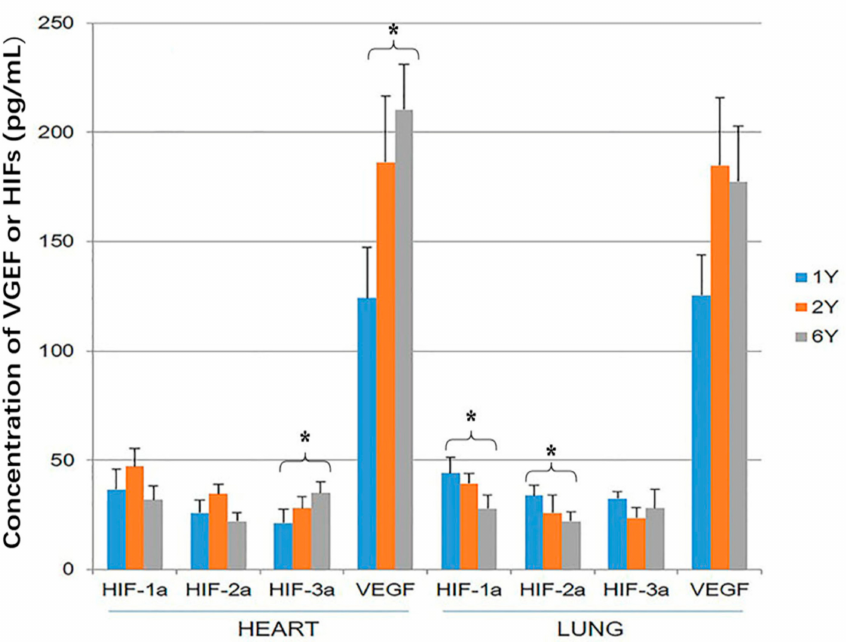
Figure 4. Hypoxia-inducible factor (HIF)-1 α , HIF-2 α , HIF-3 α and vascular endothelial growth factor (VEGF) expression in the heart and lung of Tibetan sheep were measured by ELISA. Values are means ± SD ( n = 10). * indicates a significant di ff erence in expression between 1-year-old and 6-year-old sheep ( p <